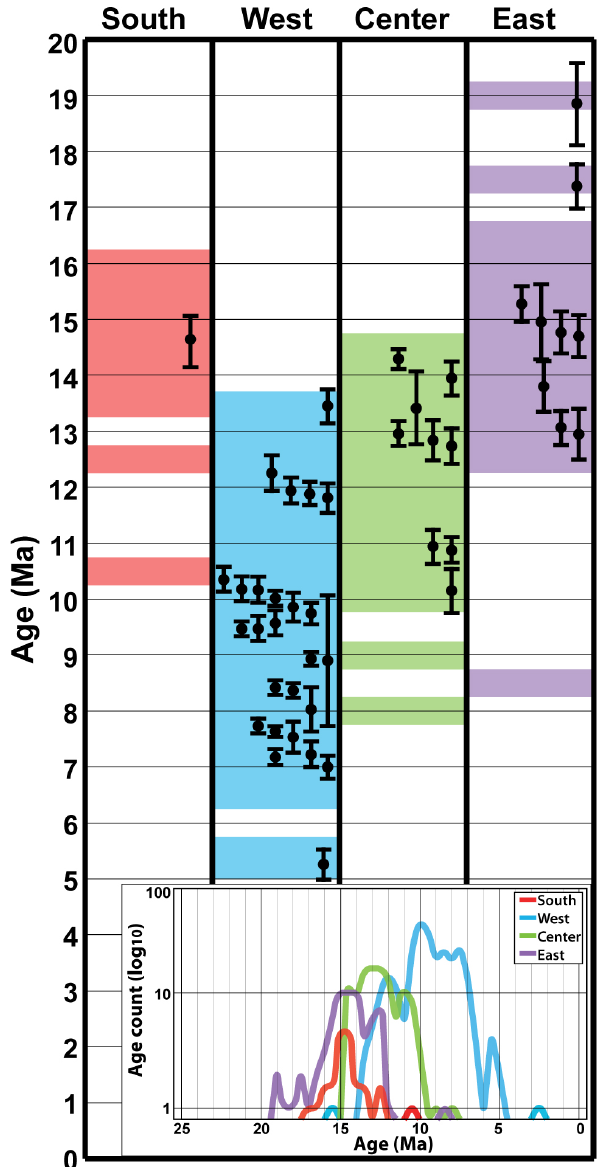
Figure 4. Time diagram combining the overall age recording time from the inset and weighted mean ages of all samples from the Lep- ontine Dome. The inset shows an age probability density plot rep- resenting the data set of each region (Fig. 1) according to the num- ber of ages per 0.5Myr interval. Black error bars indicate weighted mean ages from this